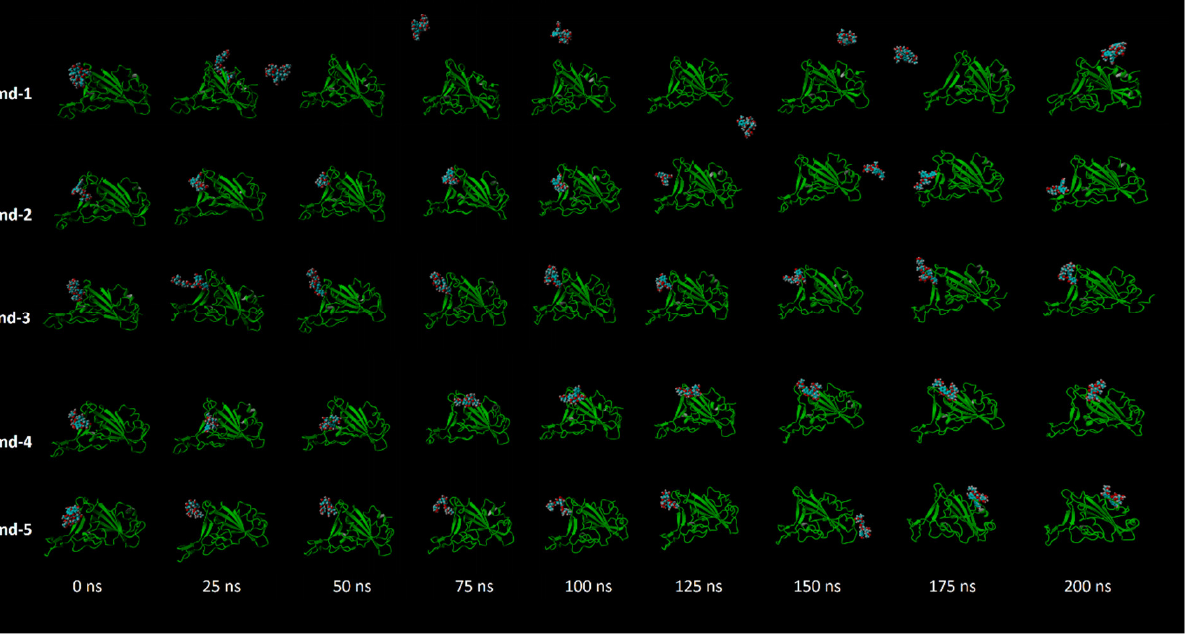
Figure 6. Snapshots for the movement of the studied five compounds inside the binding cavity of Omicron BA.1 during the MD simulation period.